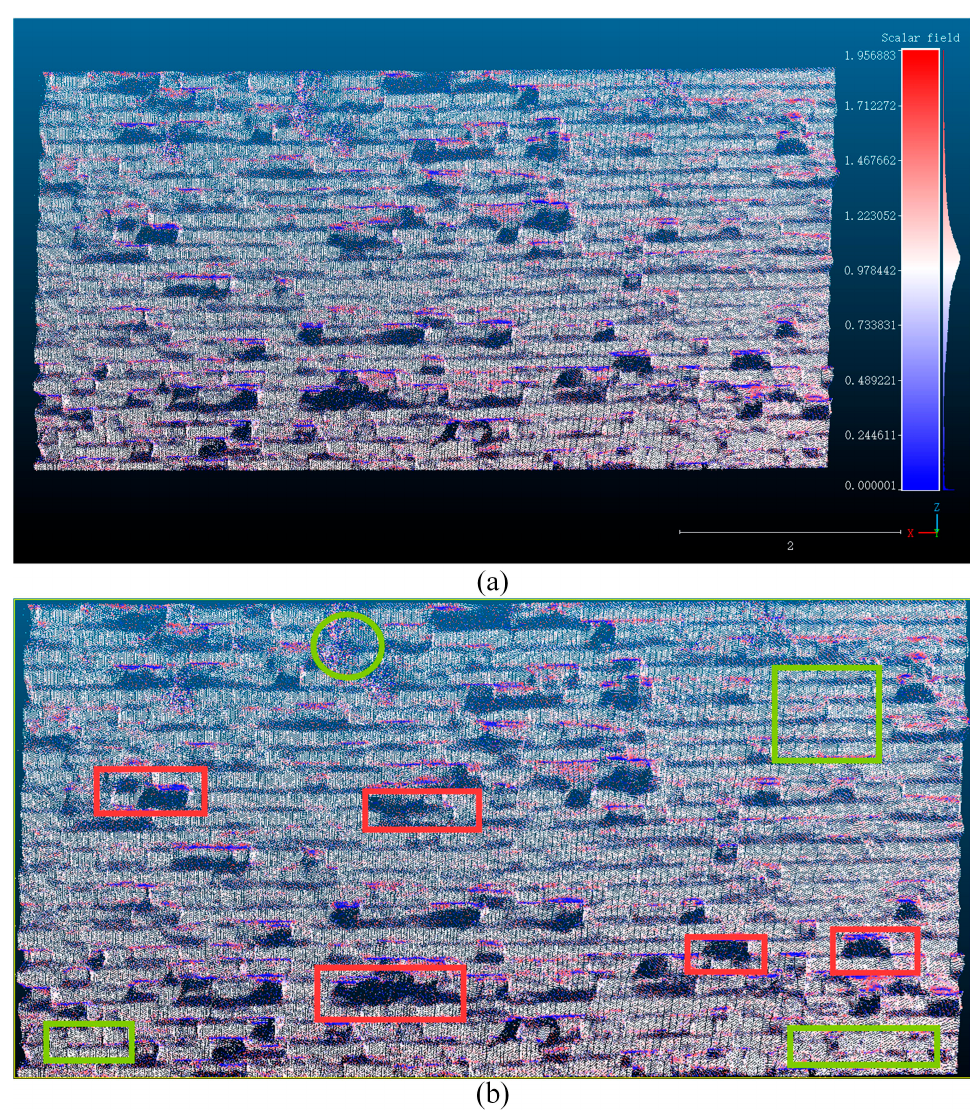
Figure 24. ( a ) Visualization of Normal Vector. ( b ) Defect analysis diagram. (The red boxes indicate the detachment of bricks, the green boxes indicate cracks in the wall, and the green circle is the area where the wall has been damaged by vegetation).